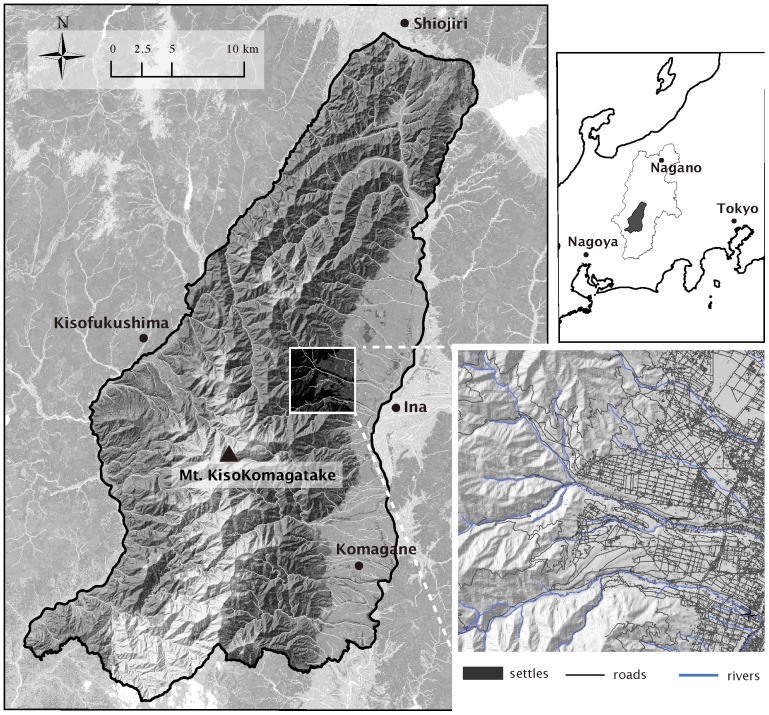
The study area of 1,0232 (35°48′27N, 137°49′47E) including the central Japan Alps located between Ina and Kiso valley, the southern part of Nagano prefecture in the Honshu island of Japan.The example section (bottom right) has a typical distribution of the landscape features that proved most important in the production of human-bear boundary maps.